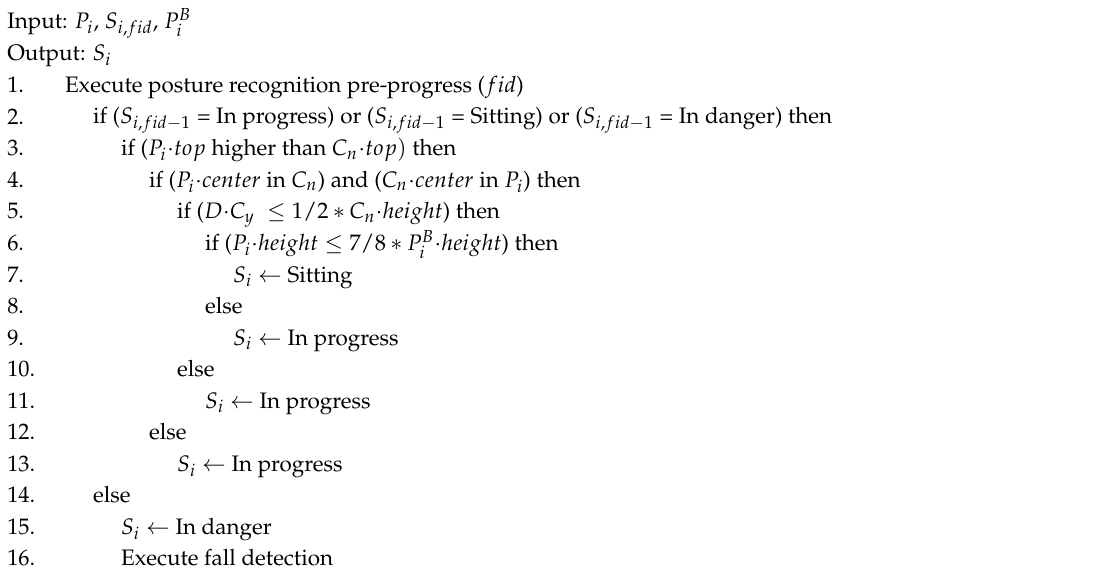
Algorithm 6 Posture recognition (between in progress, sitting, and in